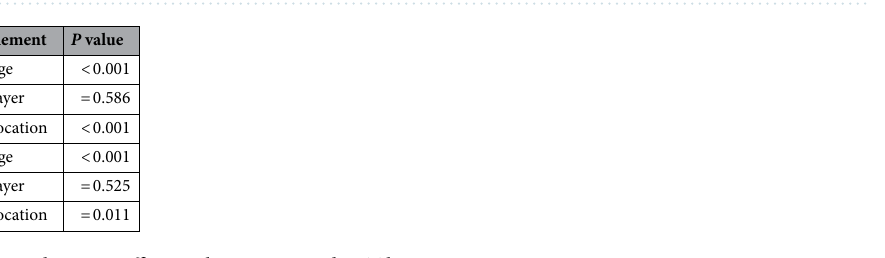
Table 8. The correlation coefficients between E and HIT by